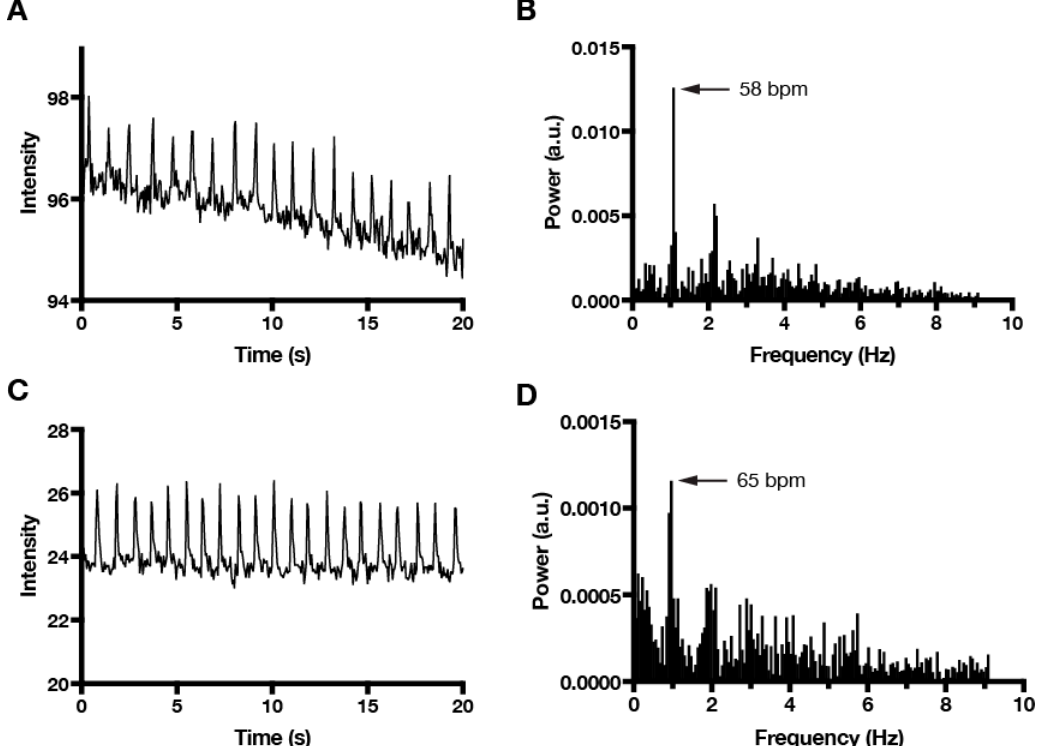
Figure 4. Comparison of cardiomyocyte contraction and calcium transients using FFT analysis. ( A ) Time series plot of cardiomyocyte contractions measured by phase-contrast intensity fluctuations and ( B ) corresponding FFT plot that identifies the dominant beating frequency (58 bpm). ( C ) Time series plot of cardiomyocyte calcium transients that were measured by Fluo-4 fluorescence intensity fluctuations in the same beating area as (A). Video S2 shows Fluo-4 imaging with the ROI (green square) used to measure intensity fluctuations. ( D ) FFT plot of Fluo-4 data identifies a dominant beating frequency (65 bpm) based on calcium transients that is similar to the contraction frequency that is based on phase-contrast imaging. Sampling frequency was 18 Hz for both imaging modalities.